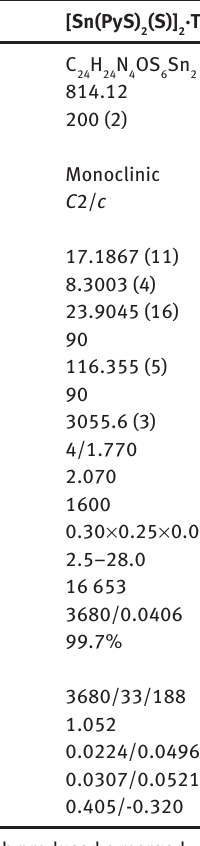
Table 4 Crystallographic parameters of data collection and structure refinement for the crystal structures of Sn(PyS)